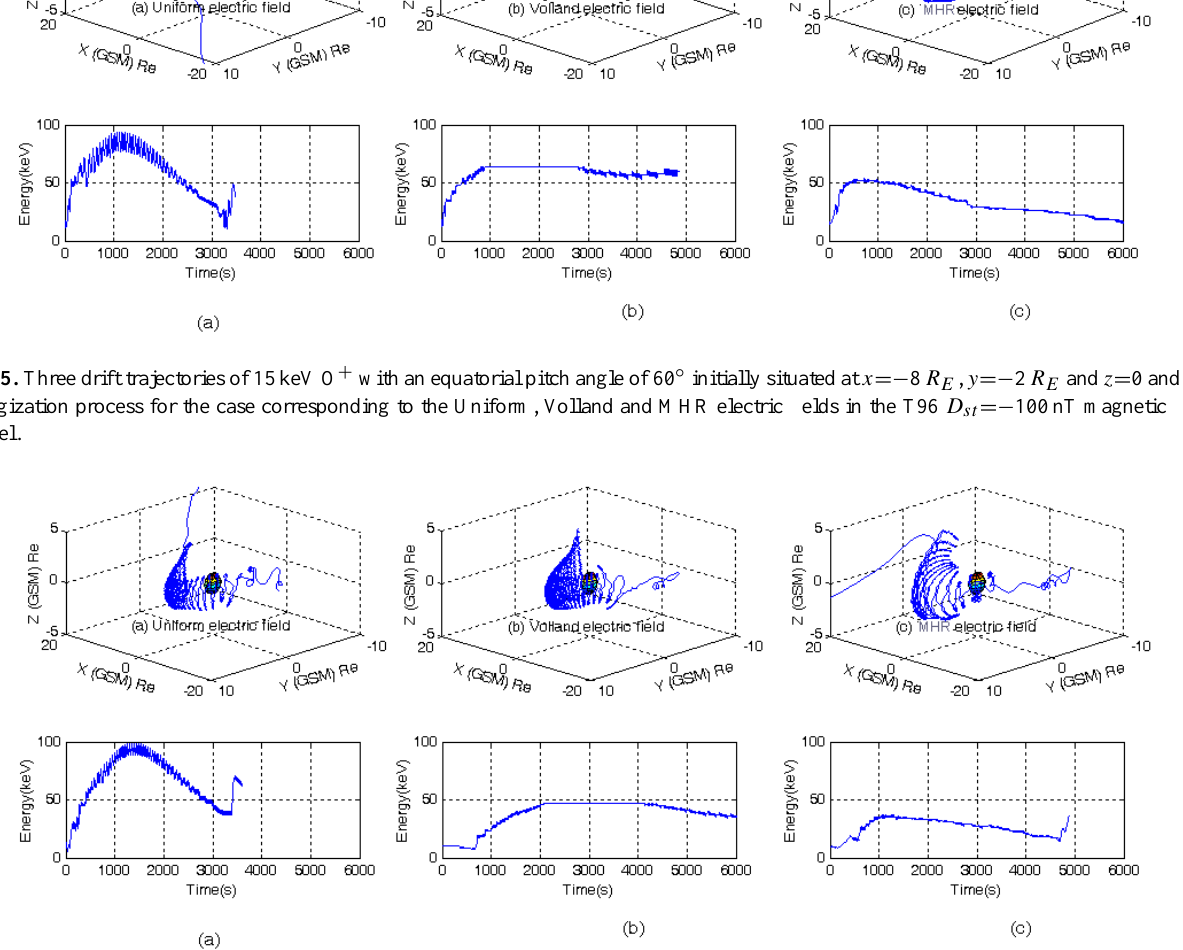
Fig. 6. Three drift trajectories of 10keV O + with an equatorial pitch angle of 60 ◦ initially situated at x =− 12 R E , y =− 3 R E and z = 0 and the energization process for the case corresponding to the Uniform, Volland and MHR electric fields in the T96 with D st =− 100nT magnetic field